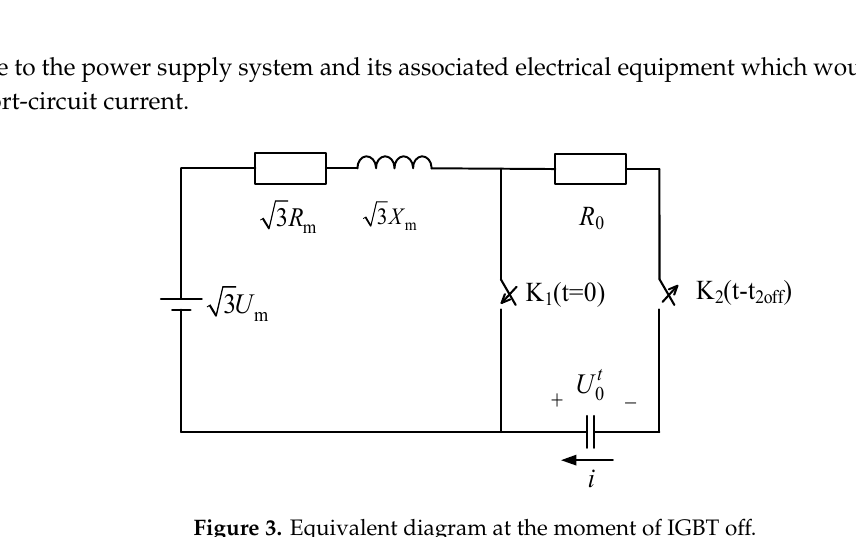
Figure 3. Equivalent diagram at the moment of IGBT off.